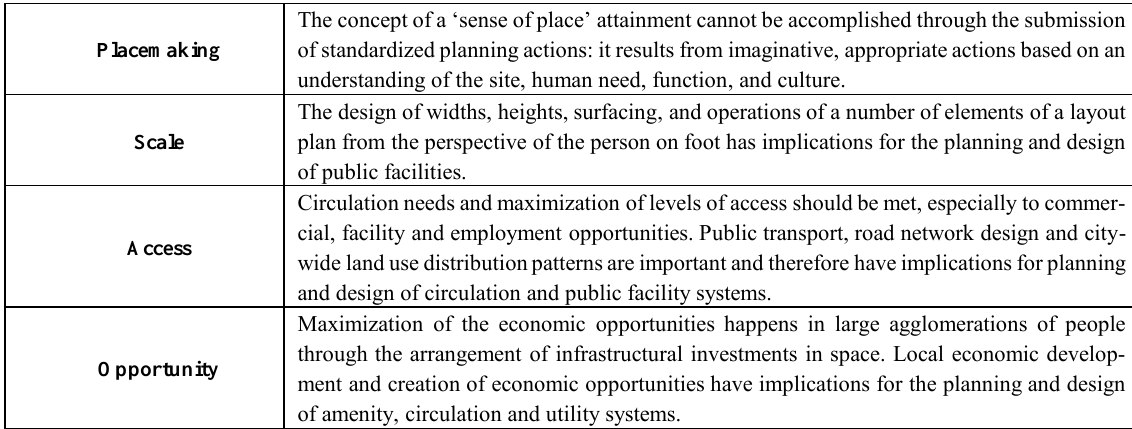
Table 2: Behrens and Watson’s spatial planning principles for the best practice